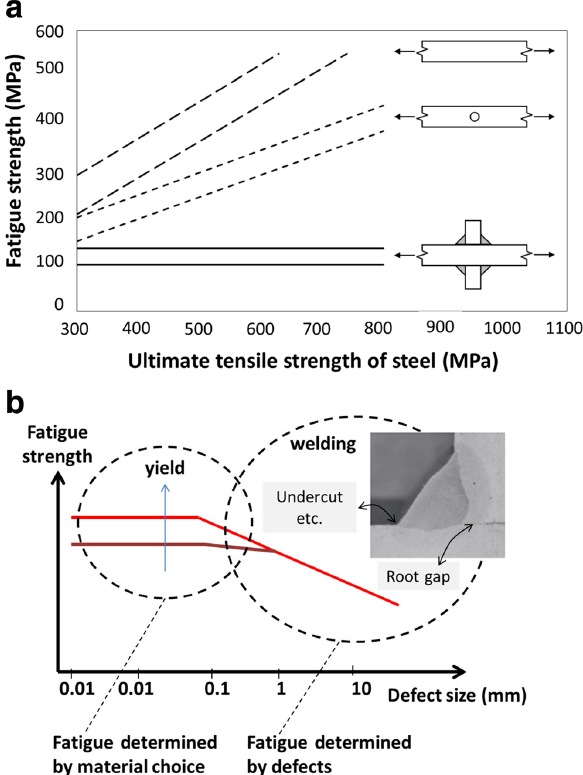
Figure 10. ( a ) Schematic illustration of fatigue strength in base material and notched and welded components. ( b ) Kitagawa diagram, fatigue strength versus defect size, with indicated weld posi- tions [16].